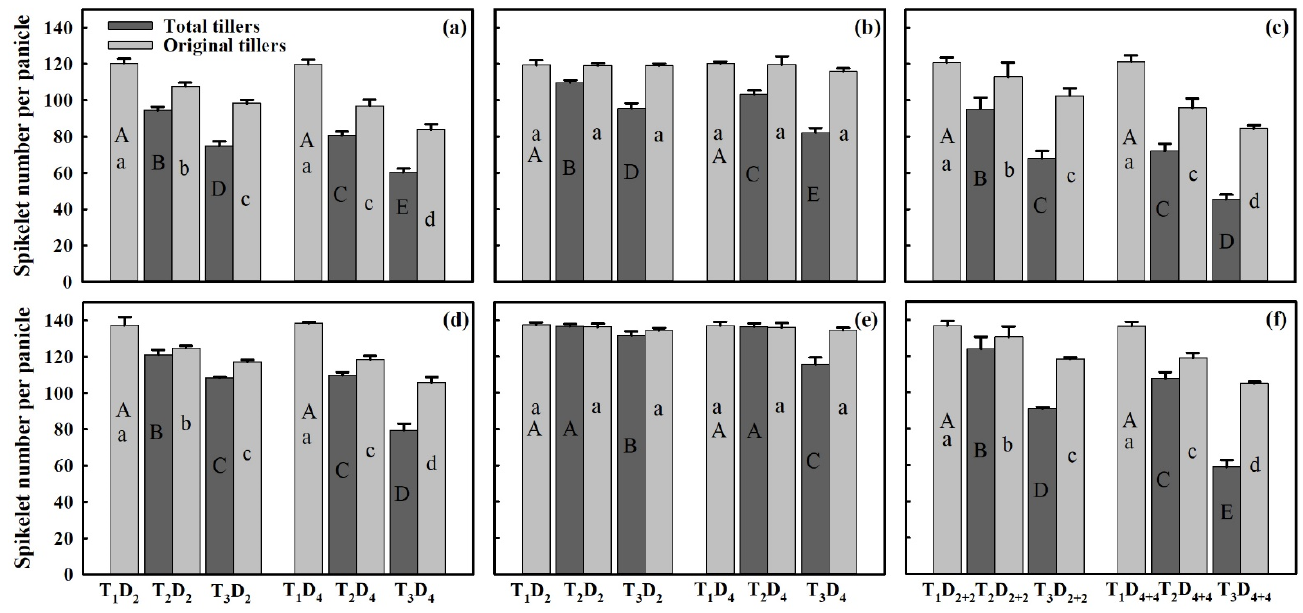
Figure 4. Effects of different high-temperature levels treatments on spikelet number per plant including total (original and regenerated tillers) and original tillers of Huaidao-5 and Wuyunjing-24 at booting (BT), flowering (FL), and combined (BT + FL) stages. ( a ) Huaidao-5 at BT treatment; ( b ) Huaidao-5 at FL treatment; ( c ) Huaidao-5 at BT + FL treatment; ( d ) Wuyunjing-24 at BT treatment; ( e ) Wuyunjing-24 at FL treatment; ( f ) Wuyunjing-24 at BT + FL treatment. Different uppercase and lowercase letters indicate significant differences at 0.05 level for total and original tillers, respectively. Vertical bars represent the standard deviation of the mean.